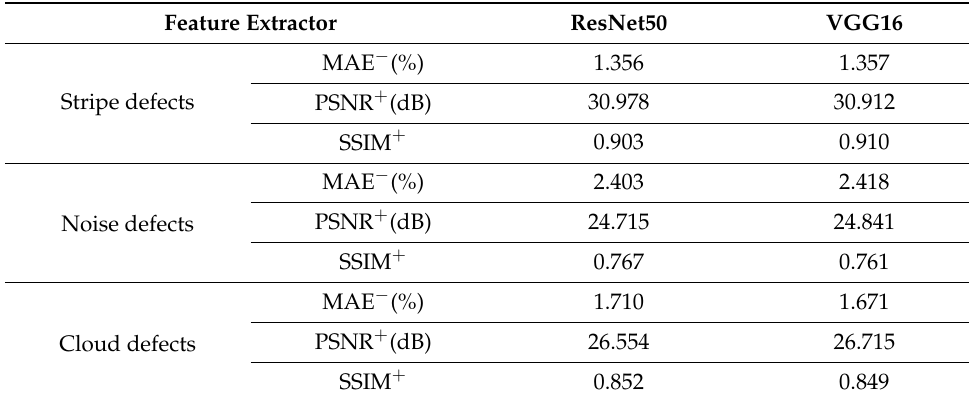
Table 10. Inpainting Quality Comparison of ResNet50 and VGG16 Extractor.